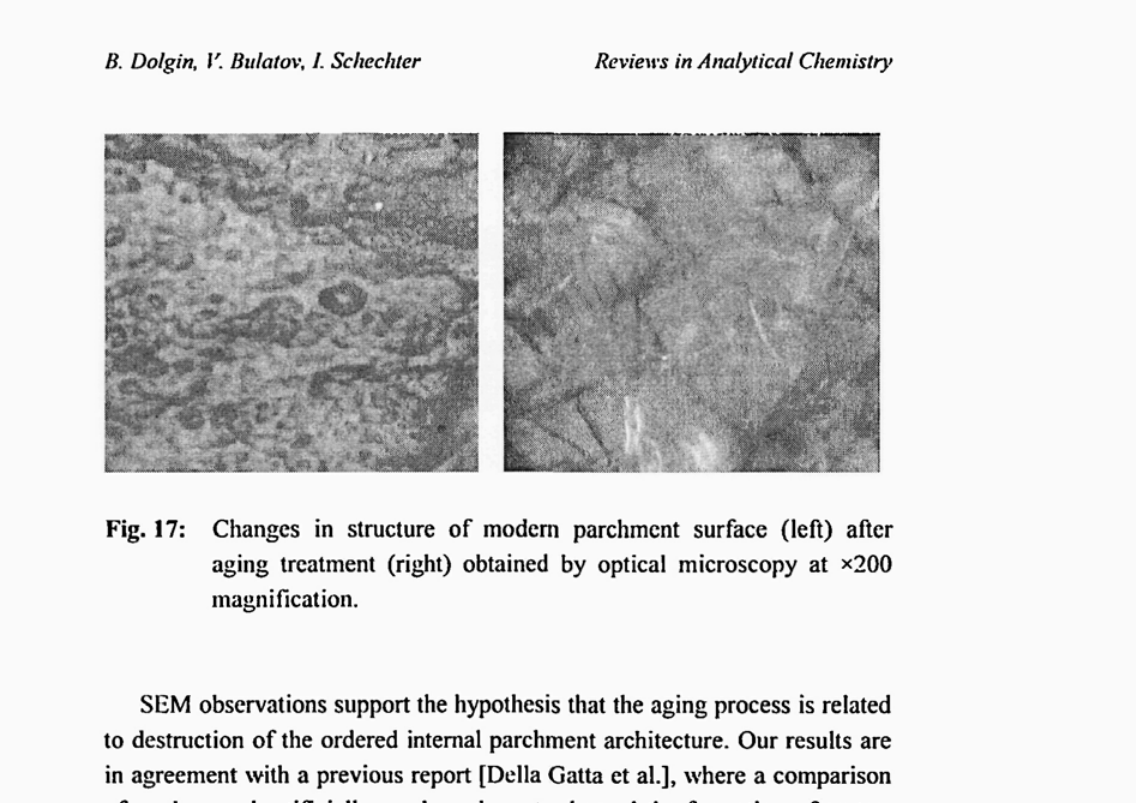
Fig. 17: Changes in structure of modern parchment surface (left) after aging treatment (right) obtained by optical microscopy at *200